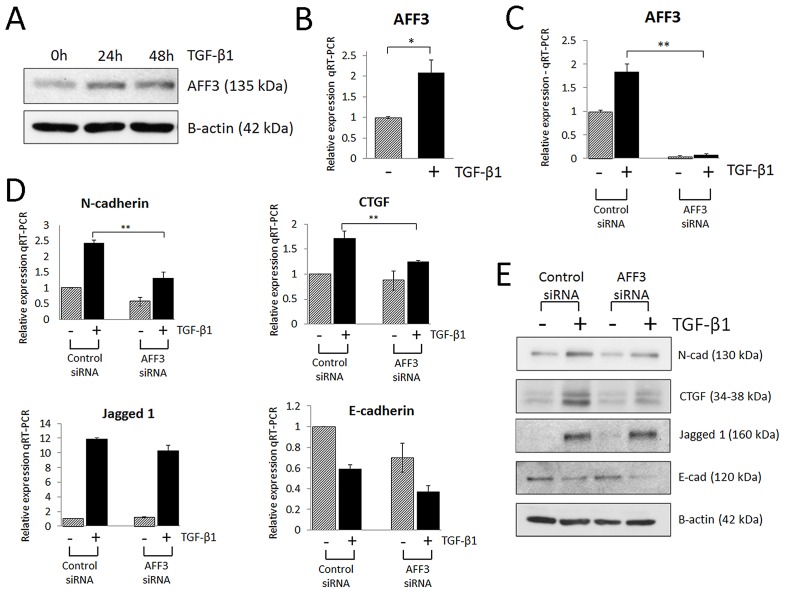
AFF3 is upregulated in renal epithelial cells (HK-2) stimulated with pro-fibrotic TGF-β1.(A) Western blot of AFF3 protein expression in HK-2 cells stimulated with TGF-β1 (5 ng/ml; 24–48 h). (B) TaqMan quantitative PCR analysis of AFF3 mRNA expression in HK-2 cells stimulated with TGF-β1 (5 ng/ml; 48 h) and (C) AFF3 mRNA expression in HK-2 cells transfected with AFF3 siRNA in the presence (black bar)/absence (grey bar) of TGF-β1 (5 ng/ml; 48 h). (D) TaqMan quantitative PCR analysis of N-cadherin, CTGF, Jagged1 and E-cadherin expression in HK-2 cells transfected with AFF3 siRNA in the presence (black bar)/absence (grey bar) of TGF-β1 (5 ng/ml; 48 h). (E) Representative Western blot of N-cadherin, CTGF, Jagged1 and E-cadherin protein responses in HK-2 cells transfected with AFF3 siRNA in the presence/absence of TGF-β1 (5 ng/ml; 48 h). HK-2 cells transfected with control siRNA were selected as a control. For TaqMan PCR, expression was normalized to GAPDH. Data are plotted as mean ± SE (n = 3; *P<0.05, **P<0.01).